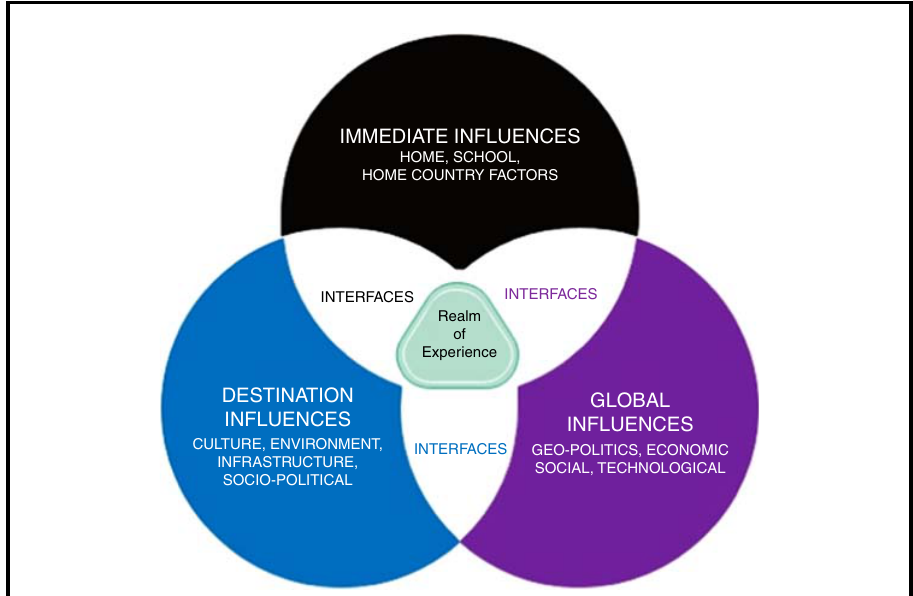
Figure 2 A theoretical model of Generation Z travel